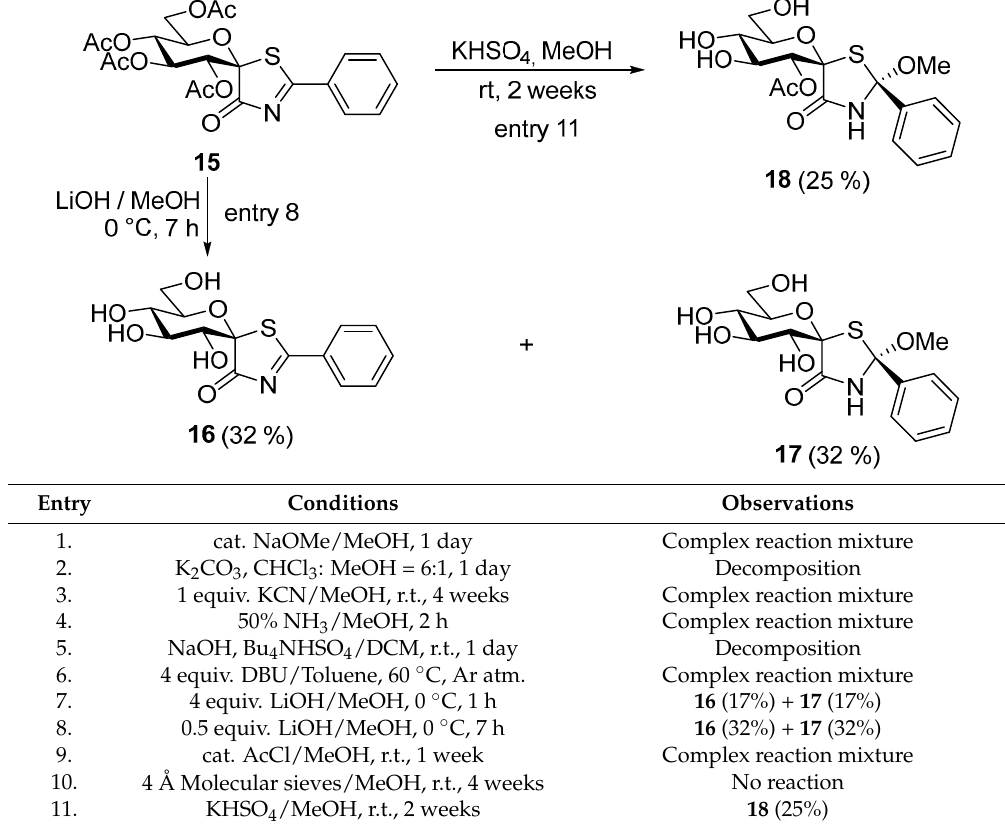
Table 2. Observations during experiments for deacetylation [29] of spiro-thiazolinone 15 .